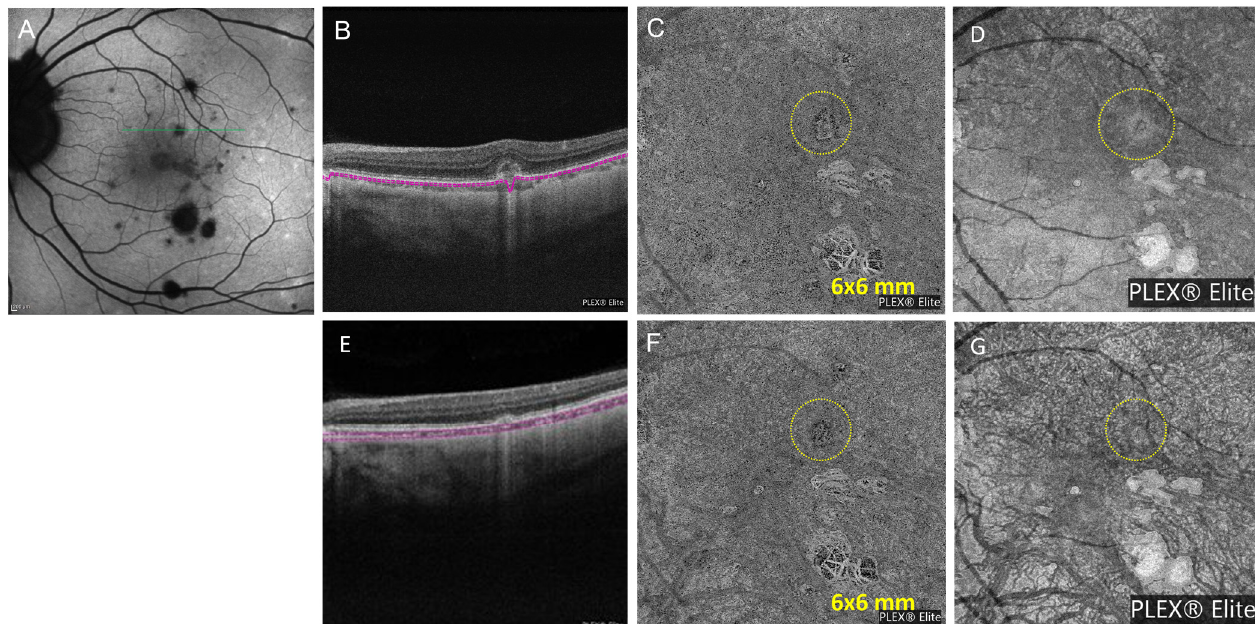
Figure 3. Case 3: Punctate inner choroiditis and inflammatory neovascular membrane. ( A ) On initial presentation, fundus autofluorescence (FAF) showed multiple hypoautofluorescent spots in the posterior pole corresponding to old choroiditis scars and one active hyperautofluorescent lesion superior to fovea in the left eye; ( B ) OCT showed retinal pigment epithelium (RPE) elevation with loss of ellipsoid zone without intra retinal fluid (IRF) in the left eye (en face segmentation boundaries in magenta); ( C ) A Plex Elite OCTA (6 mm × 6 mm) demonstrated a dense neovascular network capillary branching resembling a fine-net pattern occurring at the level of choriocapillaris (circle); ( D ) The corresponding en face structure showed the same hyperreflective lesion (circle); ( E ) Three months after initiation of steroid therapy, OCT showed resolution of retinal pigment epithelium (RPE) elevation without intraretinal fluid (IRF) in the left eye; ( F ) A Plex Elite OCTA (6 mm × 6 mm) demonstrating a regressed neovascular network at the level of choriocapillaris after intravitreal bevacizumab (circle); ( G ) The lesion shows less reflectivity than before on the corresponding en face structure (circle).